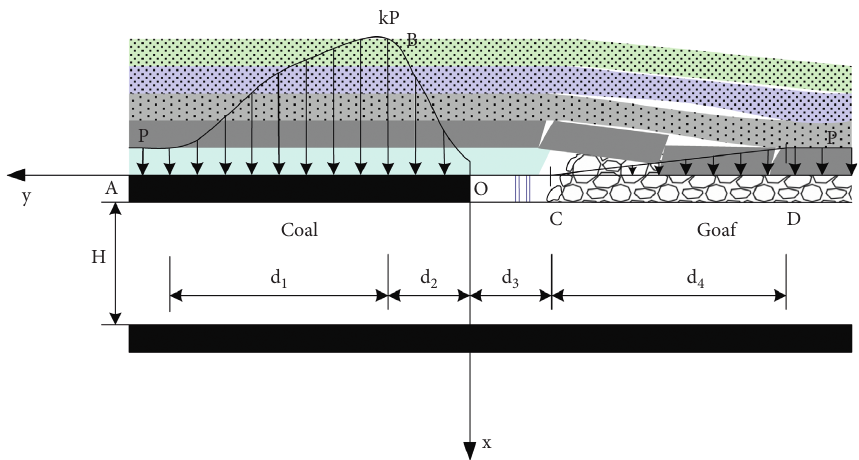
Figure 2: Abutment pressure distribution graph before and behind the working face.